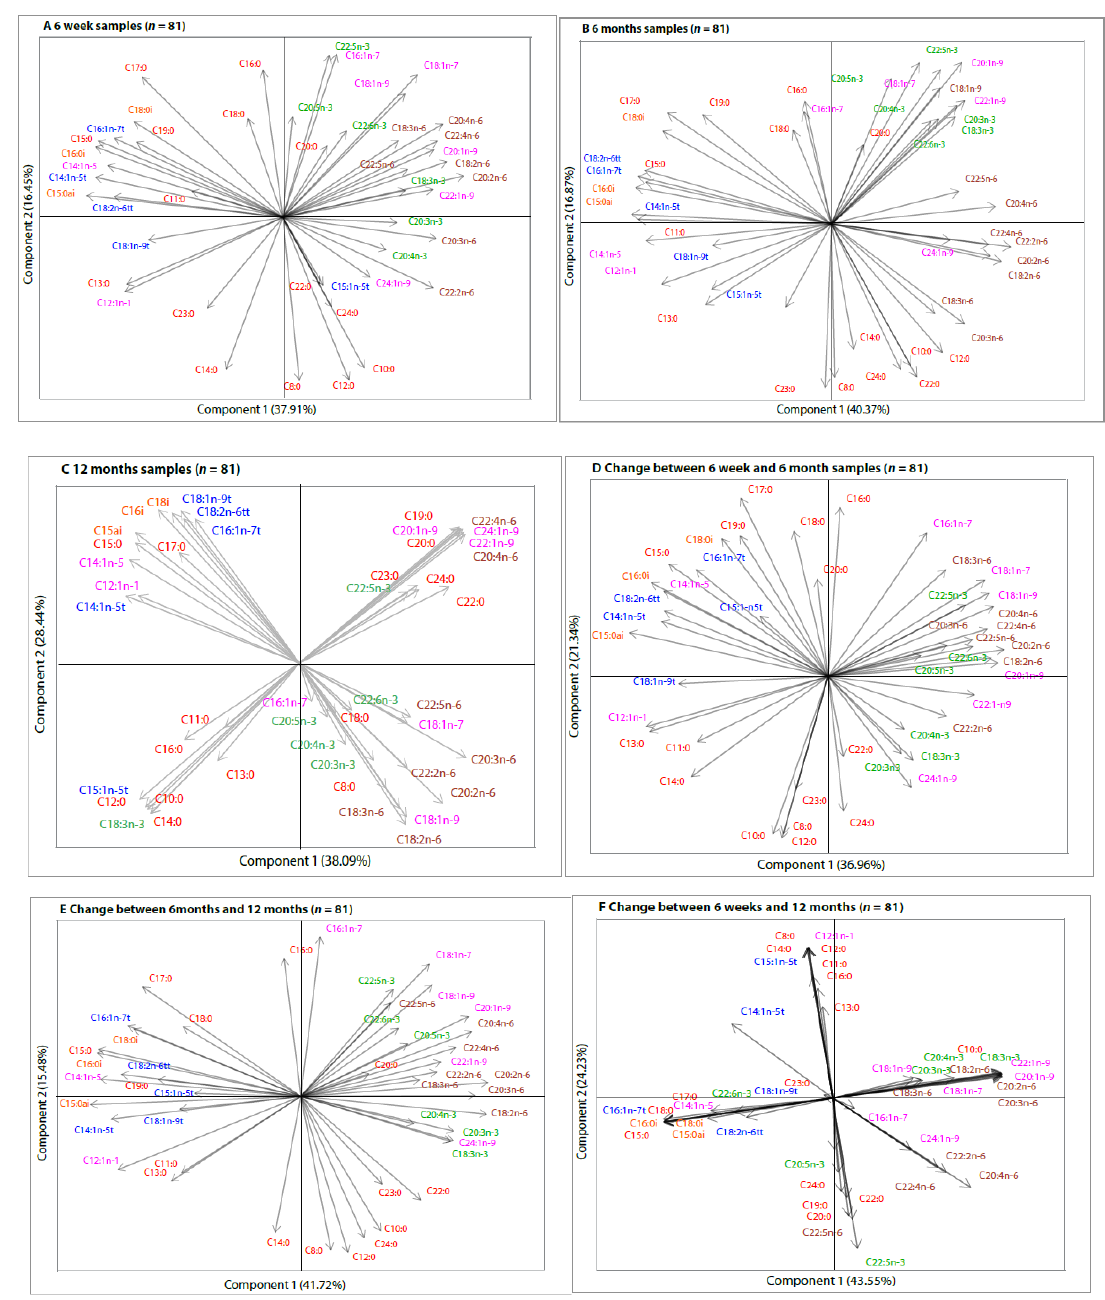
Figure 2. Compositional biplots from principal component analysis (PCA) of centered log-ratio transformed fatty acid concentrations of human milk samples collected at 6 weeks, 6 months, and 12 months ( n = 81). Colour Key: Red—Saturated fatty acids; Blue—Trans-fatty acids; Green—Omega-3 fatty acids; Pink—Monounsaturated fatty acids; Orange—Branched-chain fatty acids. Compositional biplots of fatty acids analyzed in human milk samples collected at ( A ) 6 weeks; ( B ) 6 months; ( C ) 12 months. Compositional biplots of changes in fatty acid composition between ( D ) 6 weeks and 6 months; ( E ) 6 months and 12 months ( F ) 6 weeks and 12 months.